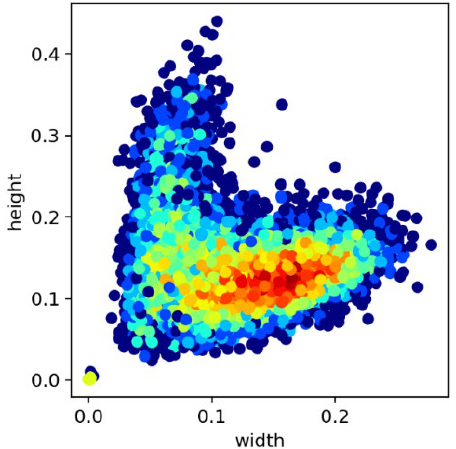
Figure 5. Heat map of the fish’s posture. As the color becomes redder, the appearance becomes more frequent. Most fish are inclined.